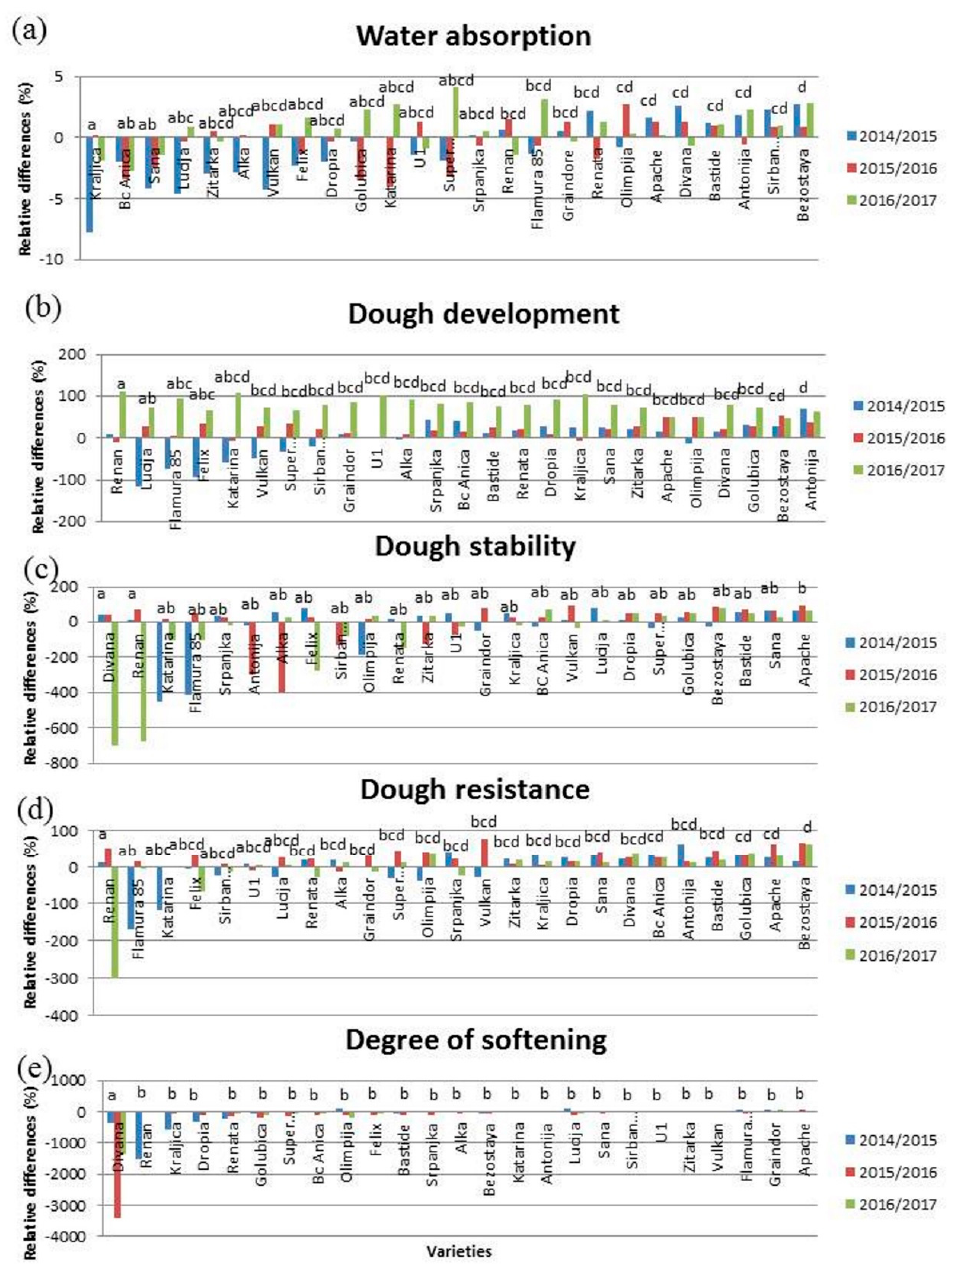
Figure 5. Relative differences of farinograph parameters (water absorption ( a ), dough development ( b ), stability ( c ), resistance ( d ), and degree of softening ( e )) between FHB-inoculated and naturally infected samples in the three years of study (2014/2015, 2015/2016, and 2016/2017) for 25 winter wheat varieties. Different lower-case letters represent significantly different values ( p < 0.05) for each wheat variety in the three years, on average.